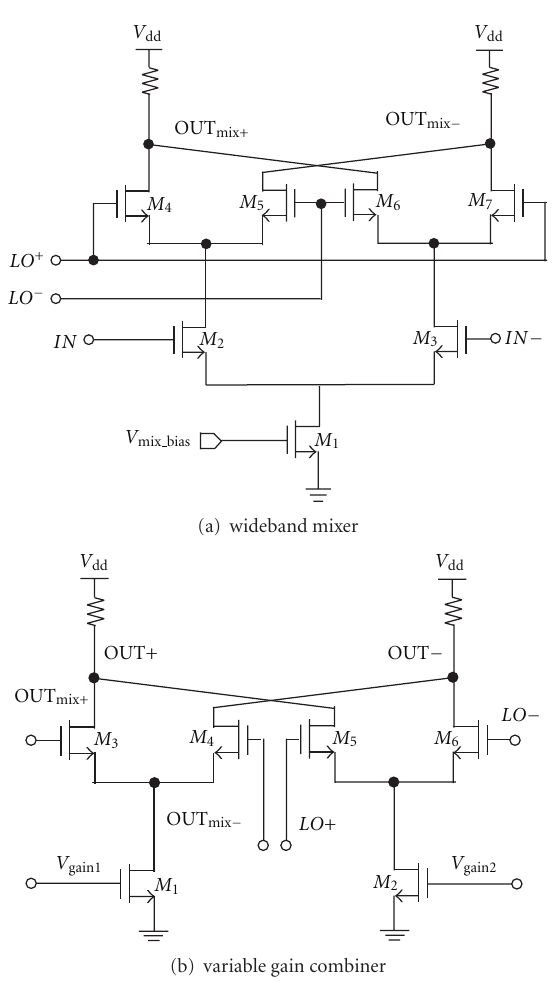
Figure 5: Circuit schematics used in the proposed wideband VCO.